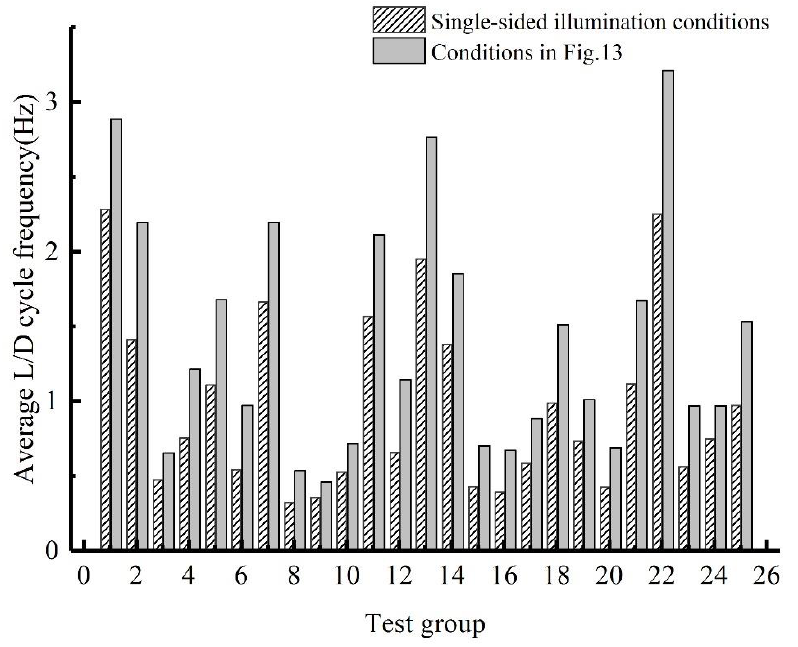
Figure 14. Average L/D cycle frequency for each orthogonal test group under single-sided illumination conditions and under the conditions shown in Figure 13.